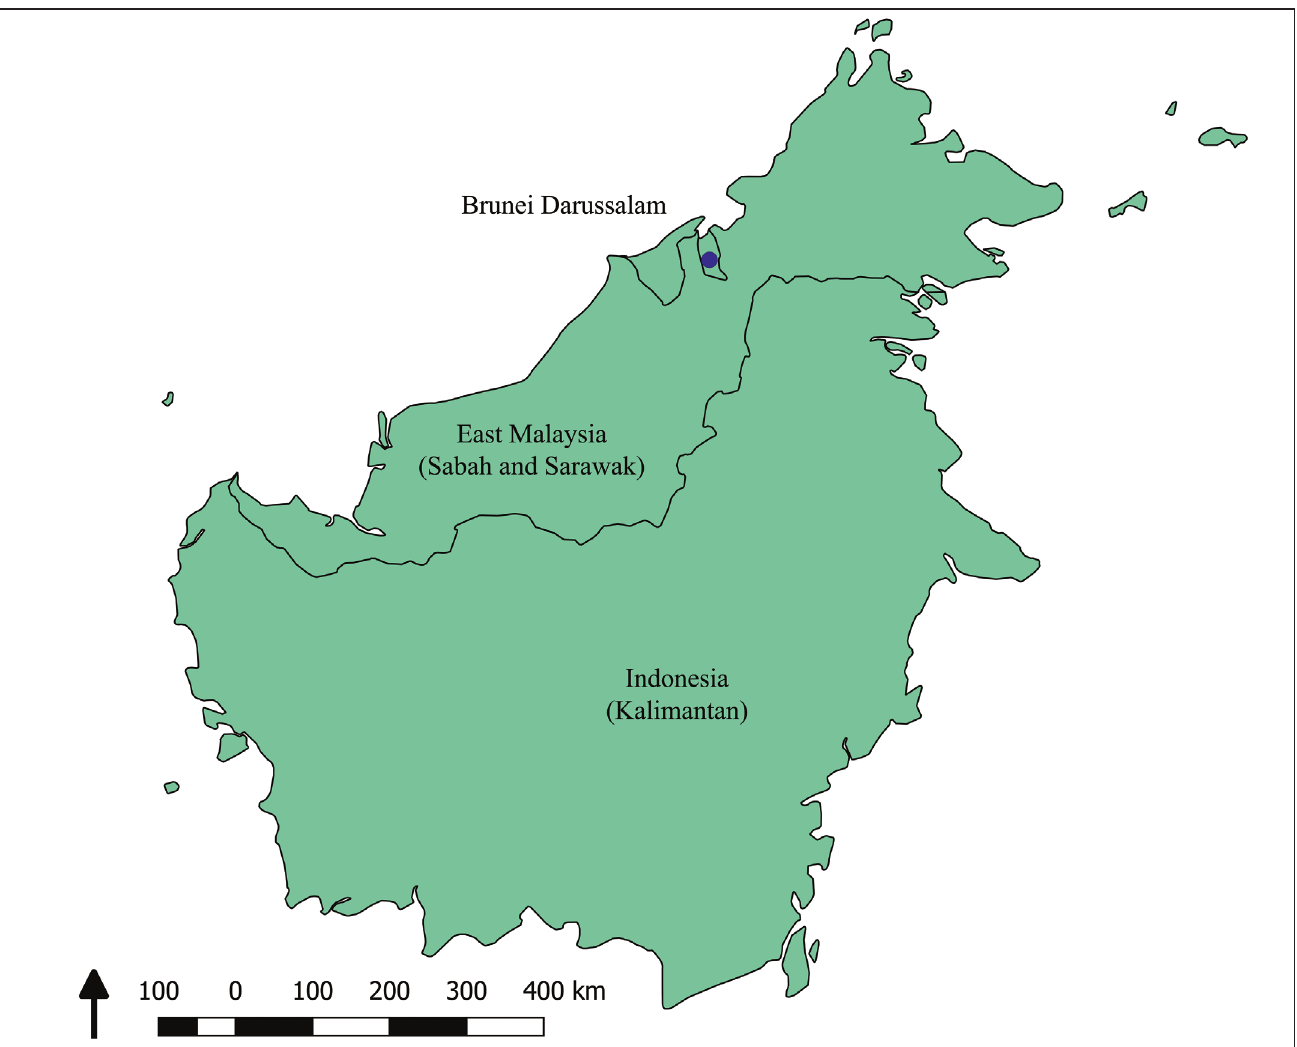
Fig. 1. Map of the island of Borneo with the dot indicating the location of KBFSC in Brunei